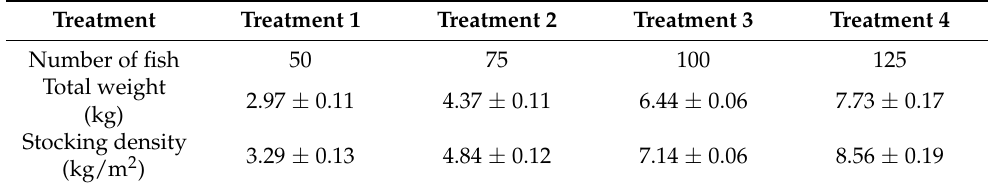
Table 1. Initial stocking information for each treatment in the experimental recirculating aquaculture system to evaluate the effect of stocking density on the productivity and stress of olive flounder Paralichthys olivaceus